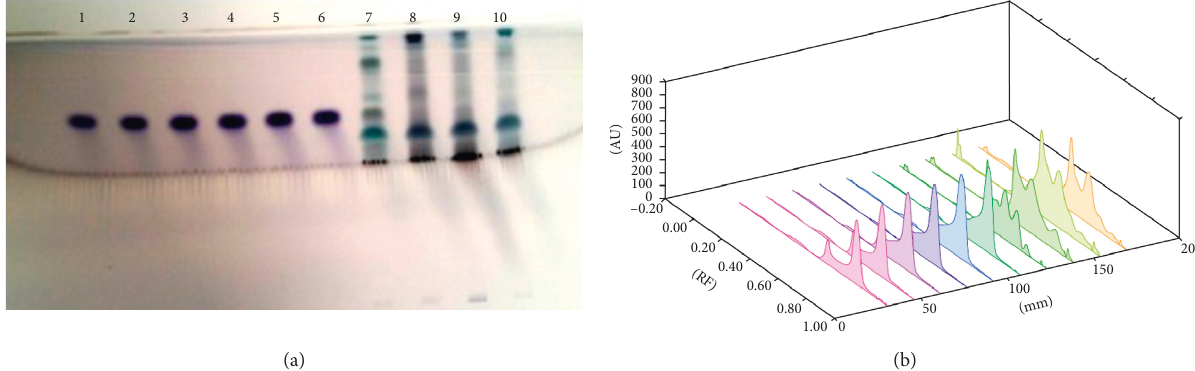
Figure 1: (a) HPTLC fingerprint profile of lupeol (tracks 1–6) in fruit (track 7); leaf (track 8); stem (track 9); and root (track 10) of S. xanthocarpum ; (b) 3D view of densitogram at 530nm.